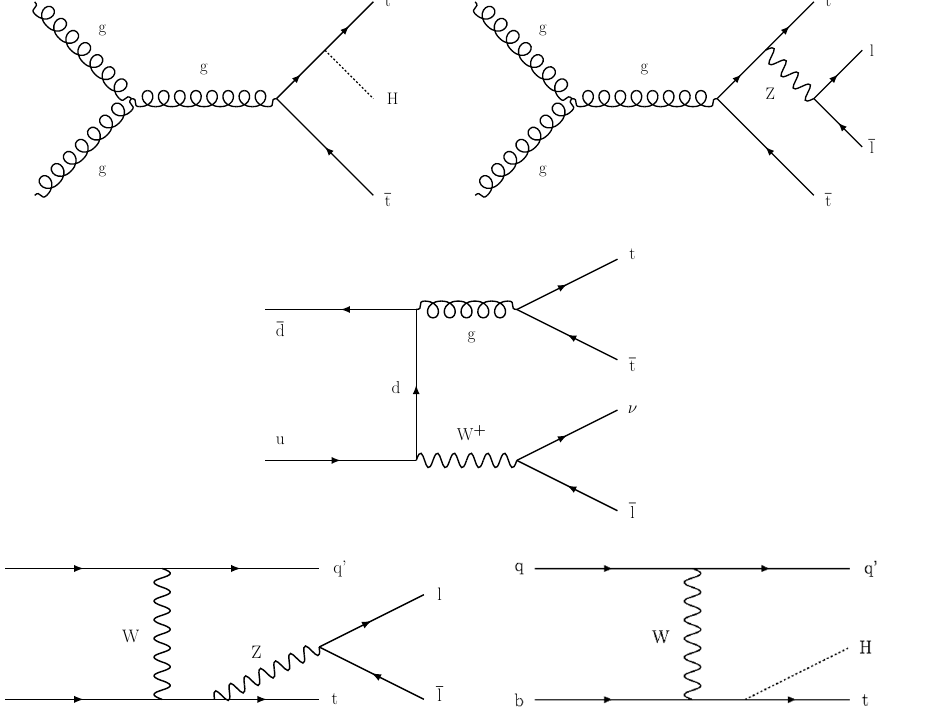
Figure 1 . Example diagrams for the five signal processes considered in this analysis: ttH , ttll , ttl (cid:23) , tllq , and tHq